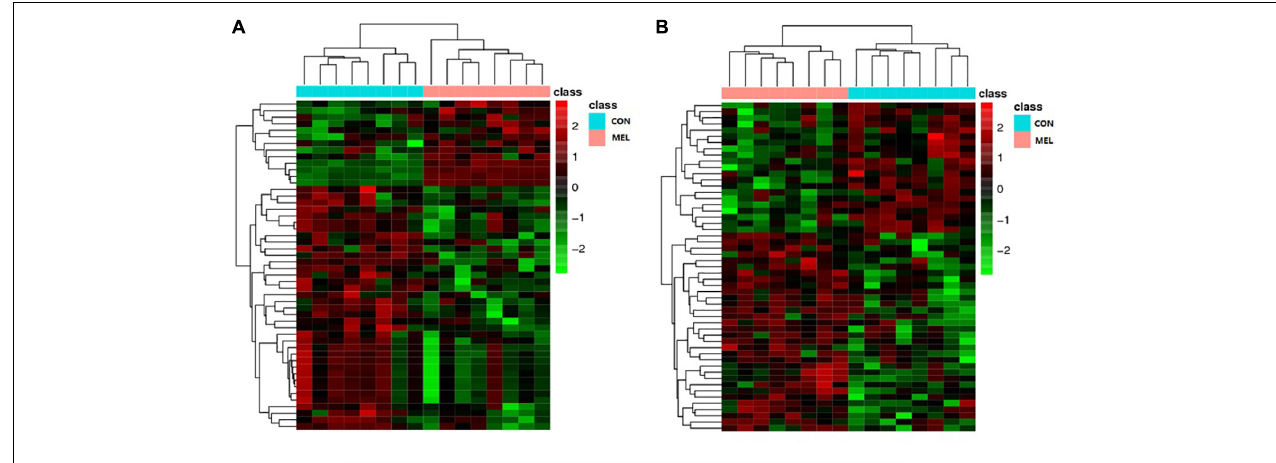
FIGURE 4 | The heat maps of overall differential metabolites from CON and MEL groups in positive (A) and negative (B) mode. Each line represents a differential metabolite and each cross represents a muscle sample. Different colors represent different higher abundance intensity (mean value acquired from all detected samples of the same group).